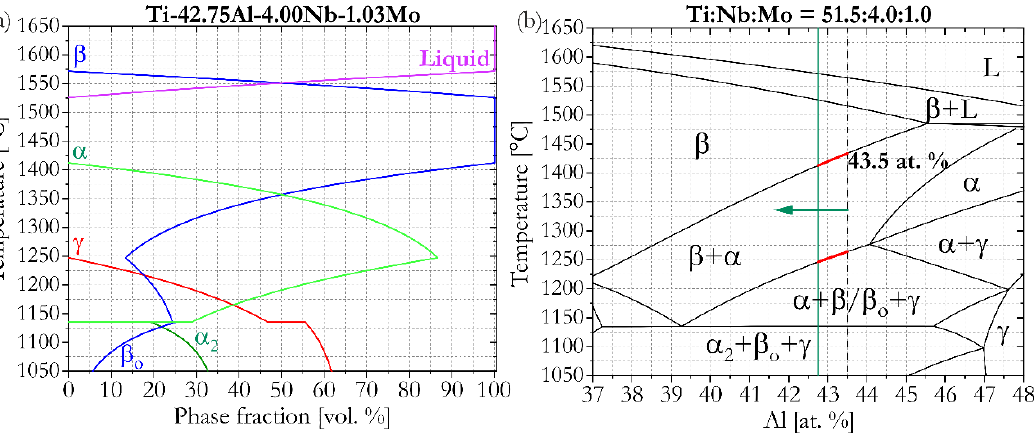
Figure 4. ( a ) Calculated phase fraction diagram for the actual chemistry of the fabricated TNM specimens (Table 1) by means of CALPHAD; ( b ) respective isopleth phase diagram for the Ti-Al-Nb-Mo system for the ratio Ti:Nb:Mo of 51.5:4.0:1.0. The nominal composition of 43.5 at.% is marked with a dashed vertical line and the actual composition is drawn as a green vertical line. The decrease of T βT and T γS is indicated by bold red lines.